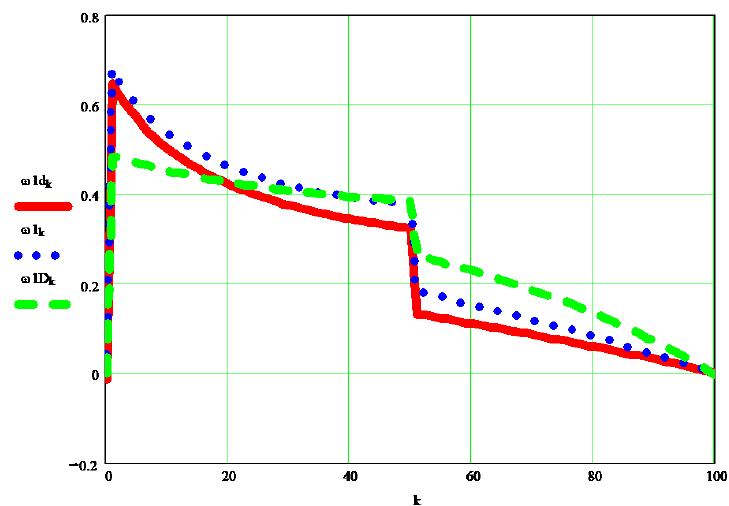
Figure 13. A comparison between the dynamic speed w 1 d [s − 1 ] obtained by the original method presented, and the dynamic speed w 1 D [s − 1 ] obtained through the classically improved method.